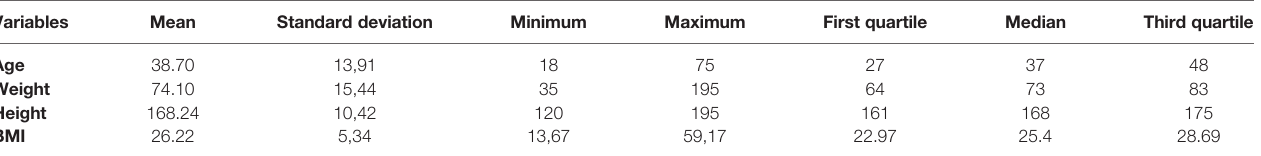
TABLE 1 | Description of weighted quanti fi ed